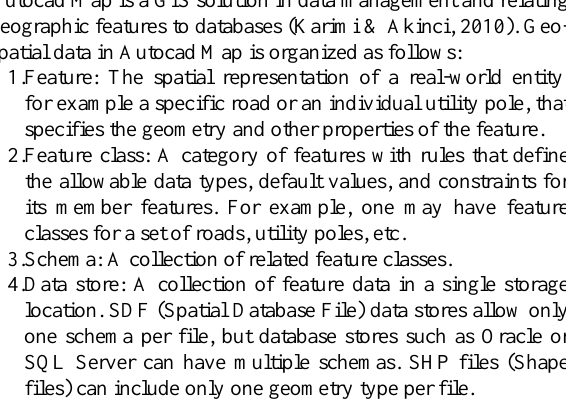
Figure 6. Example with Union command